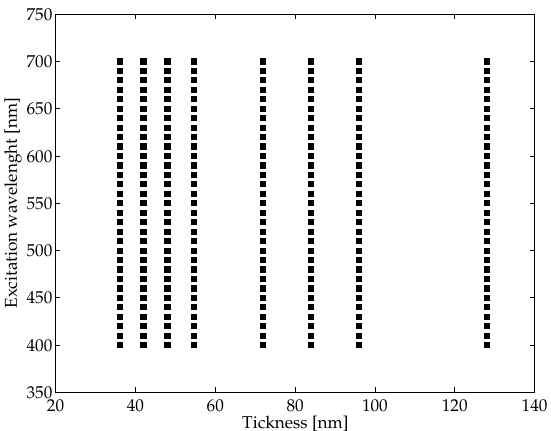
Figure 2. The simulation survey coverage in the features space concerning the excitation wavelength λ 0 and the adopted tickness t